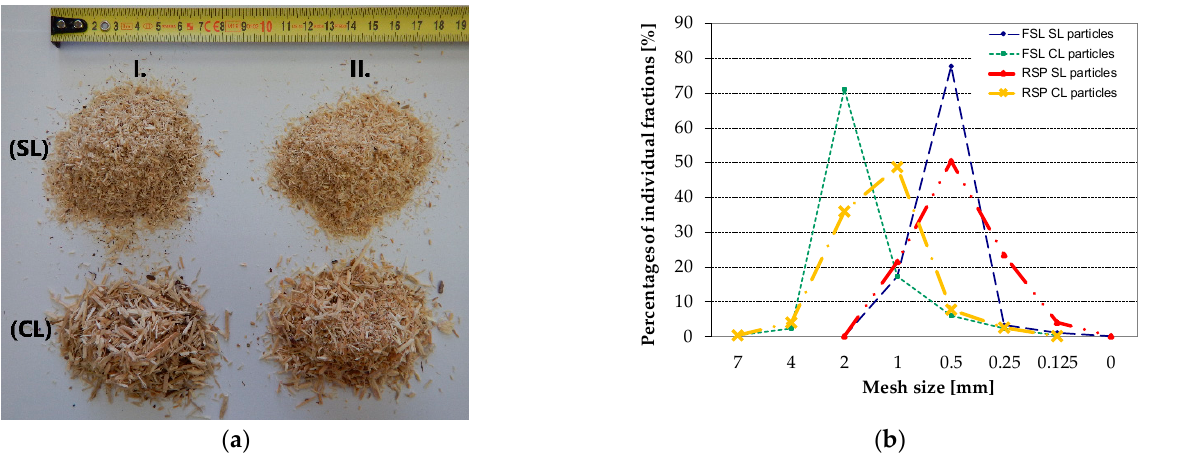
Figure 2. Particles for PBs: ( a ) Prepared from the fresh spruce logs (FSL)—type I., and from the recycled spruce pallets (RSP)—type II., at which both particle types were used in the surface layers (SL) and the core layer (CL) of PBs; ( b ) Size characteristics of particles from FSL and RSP, with percentage of individual fractions for surface layers (SL) and core layer (CL).